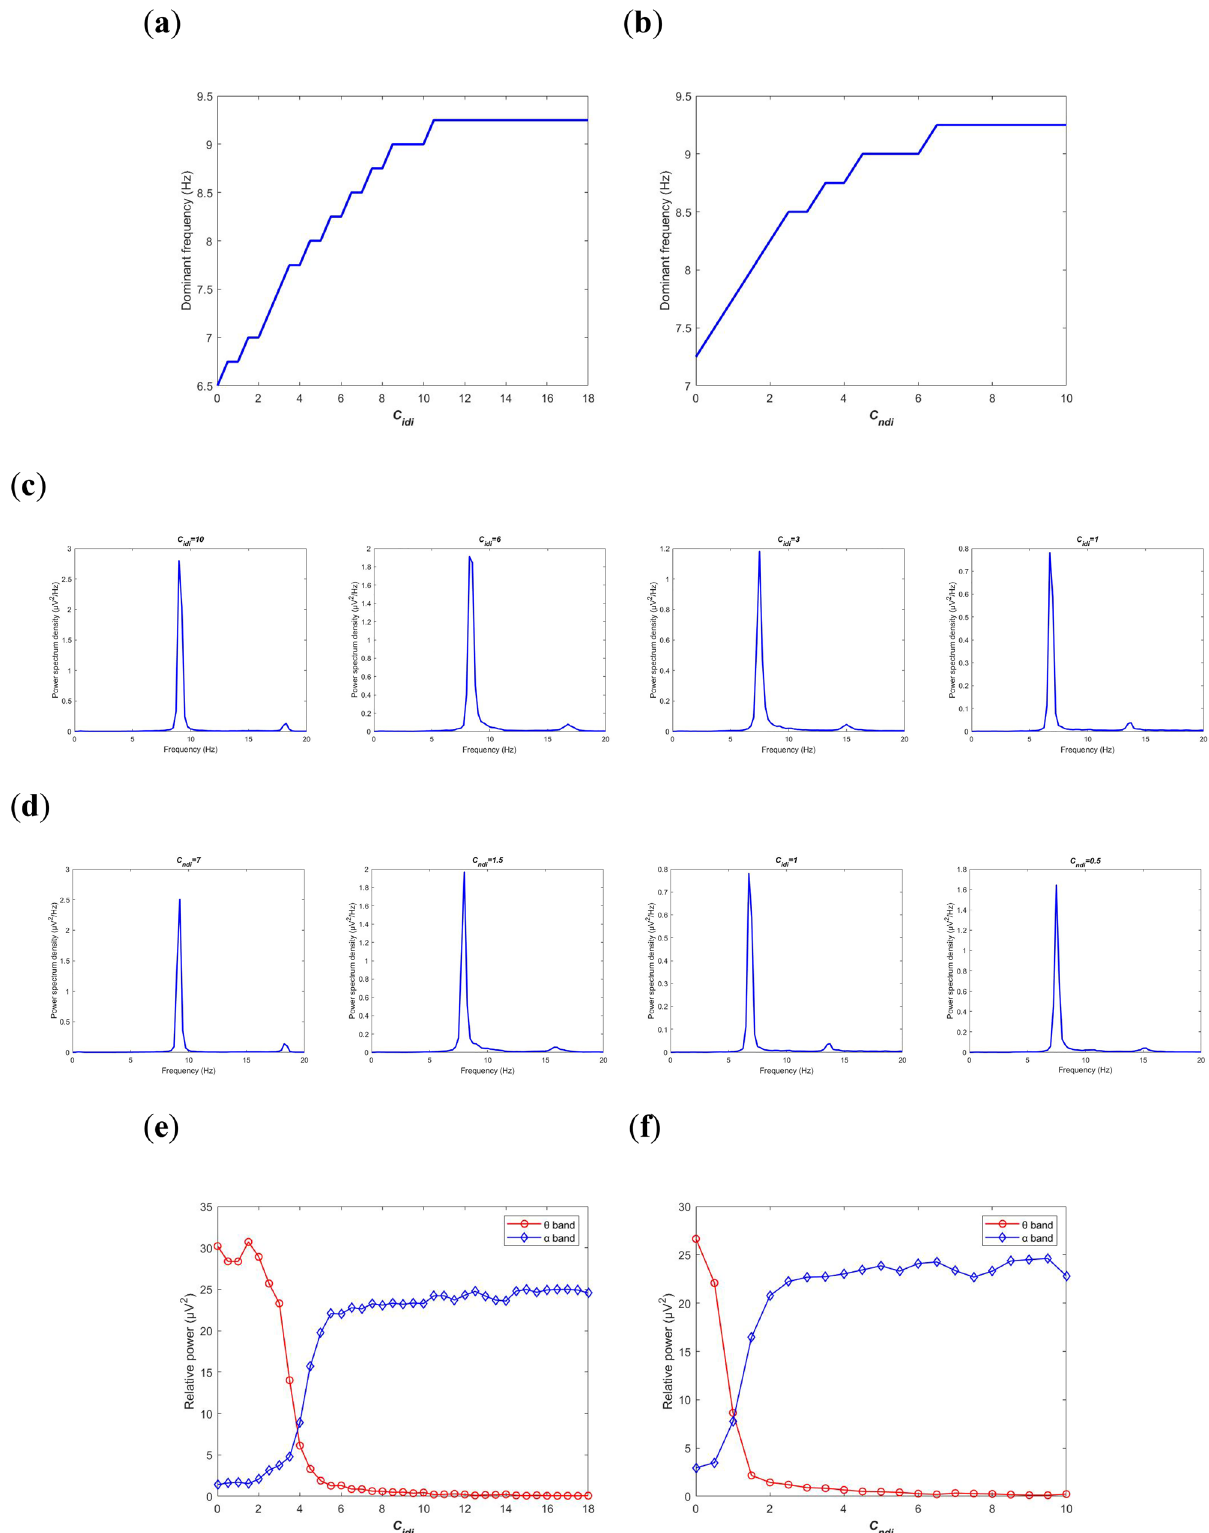
Figure 4. Power spectrum analysis of the BTC model output V t in frequency domain with decreasing of inhibitory synapse connectivity parameters C idi from PNN to IN and C ndi from PNN to TRN. Dependence of the dominant frequency of the model output on C idi ( a ) and C ndi ( b ). The individual plots of power spectrum density when C idi ( c ) and C ndi ( d ) take different values. The evolution of relative power in alpha and theta frequency bands during the reduction of C idi ( e ) and C ndi ( f